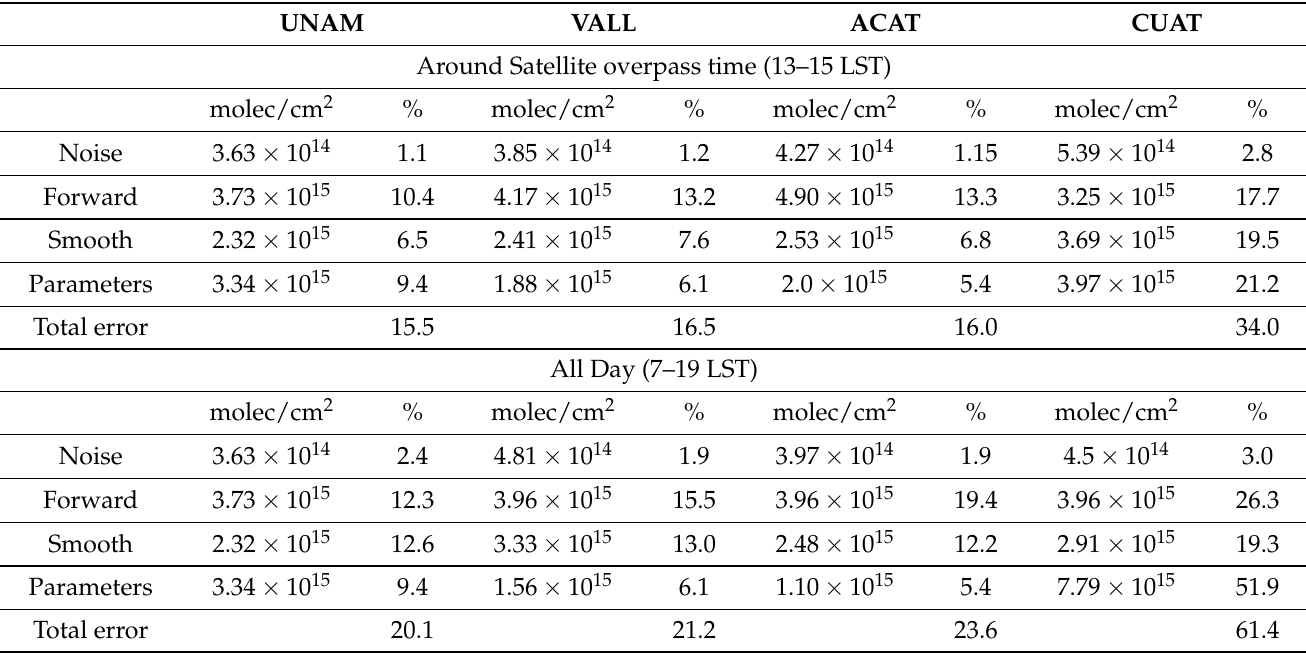
Table 1. Average errors for the data available for each MAX-DOAS site over the day and the 13–15 h LST period all the data set available for each